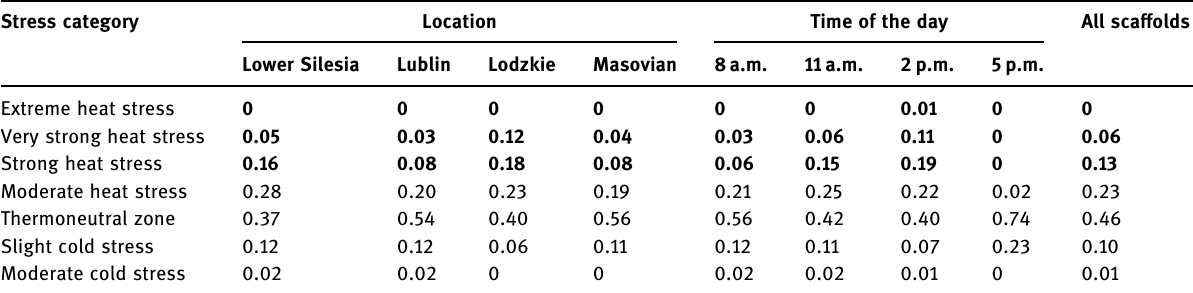
Table 4: The probability of heat stress occurring in the Lower Silesia, Lublin, Lodzkie, and Masovian voivodeships and for measurements taken at 8 a.m., 11 a.m., 2 p.m., and 5 p.m. and on all 40 sca ff olds Stress category